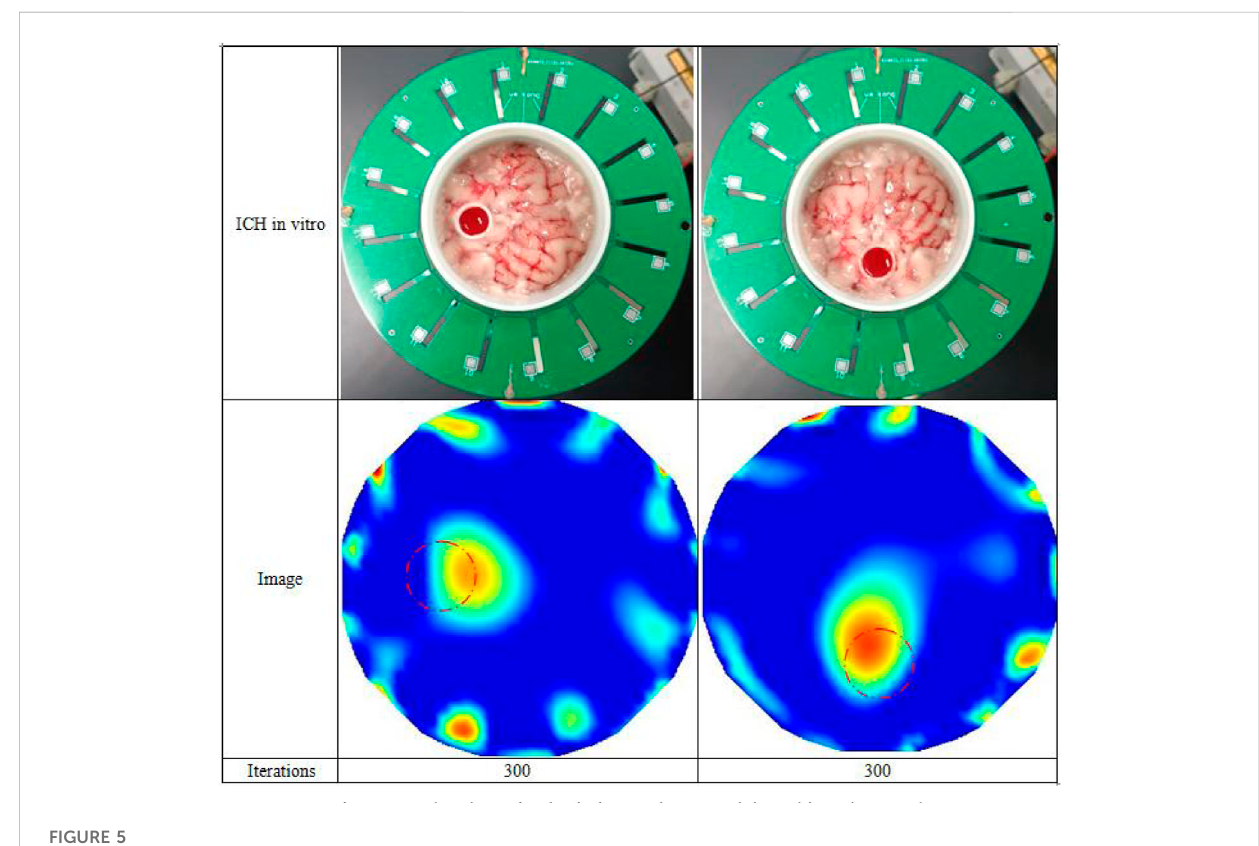
FIGURE 5 Isolated porcine brain hemorrhage models and imaging results.